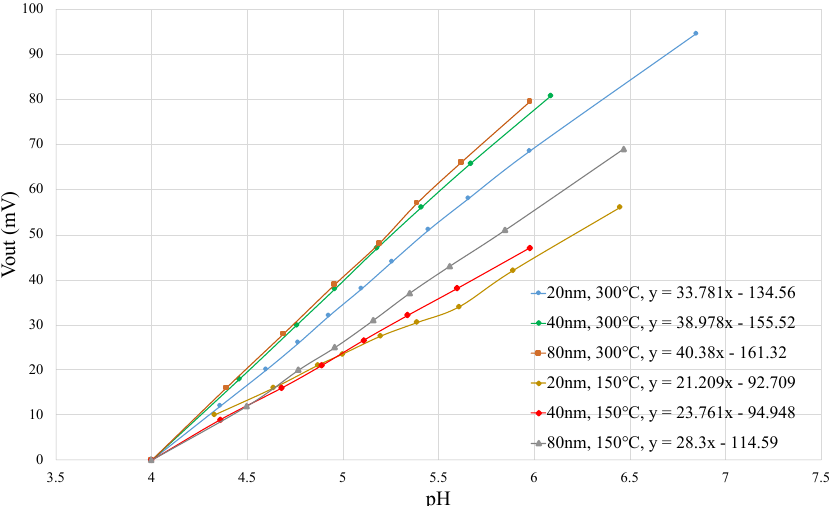
Figure 10. The pH response of the TiO 2 samples with different thickness deposited in two different temperatures of 300 °C and 150 °C.